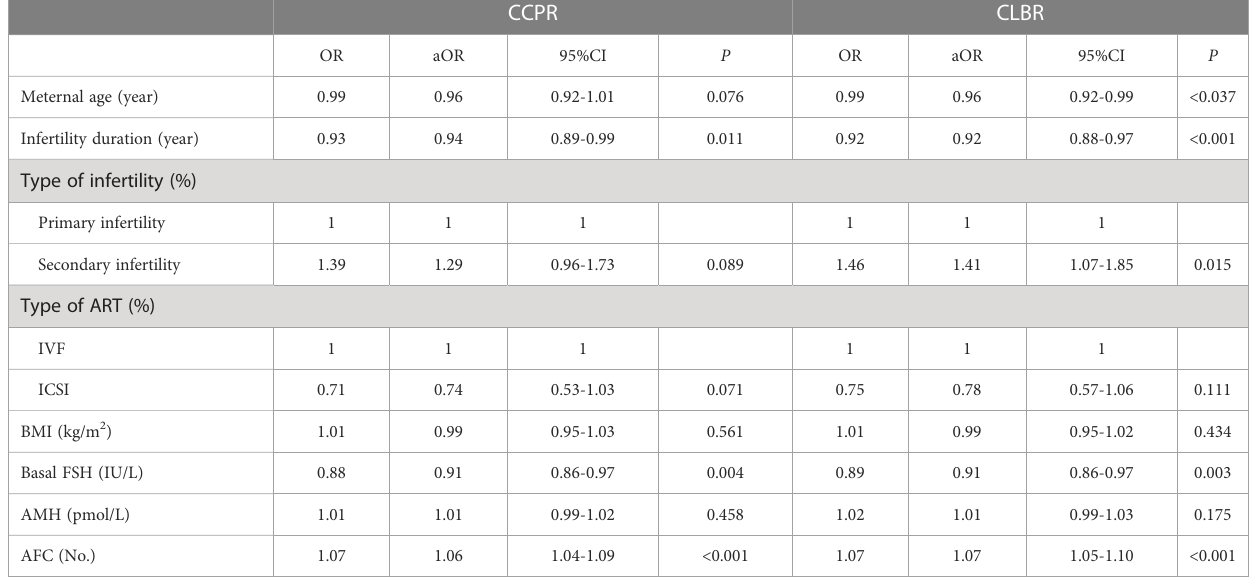
TABLE 4 Logistic regression analysis of cumulative outcomes and in fl uencing factors of patients with discrepancies between age and AMH